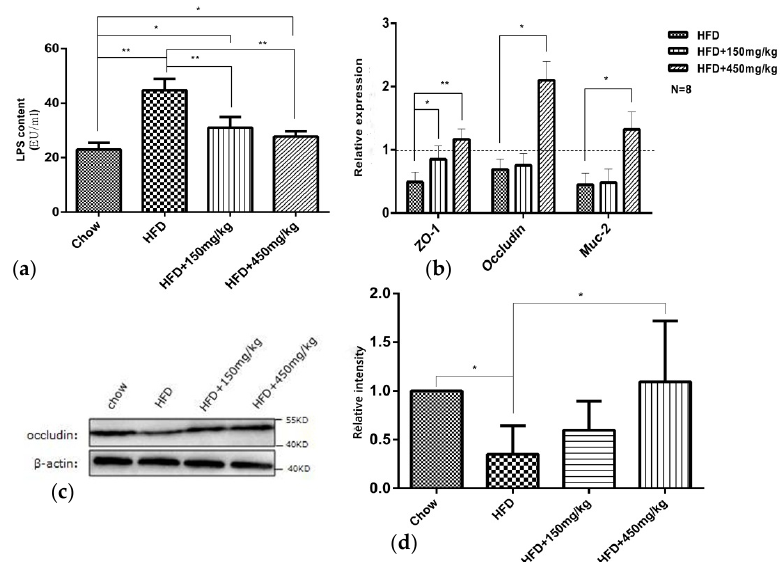
Figure 4. SIF protected intestinal mucosal integrity. ( a ) The plasma LPS concentrations was measured with the ELISA kit; ( b ) mRNA relative expressions(fold of chow) of ZO-1, occludin and Muc-2 in colon were assessed using qRT-PCR; ( c , d ) Western blots and quantification shown the protein level of occludin in colon. Error bars indicate SD. * p < 0.05, ** p < 0.005. The dashed is the chow